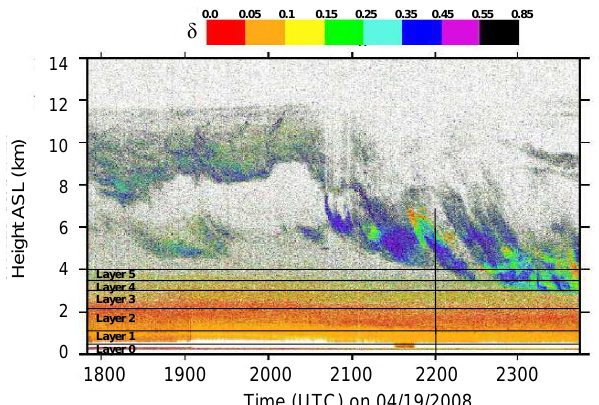
Fig. 8. Lidar depolarization ratio display collected on 19 April 2008 bracketing the OPC balloon-sonde launch (note vertical line at 22:00UTC). Layers defined in the text are marked and labeled. The vertical line at 22:00h is the time of the OPC-sonde